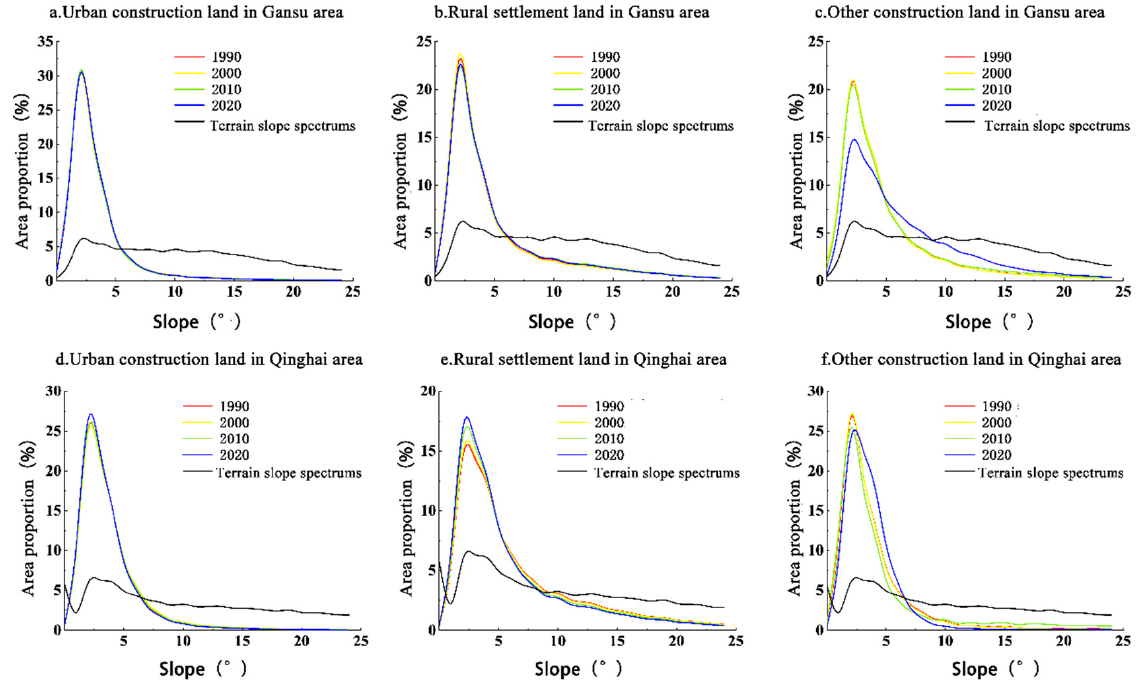
Figure 11. Terrain and construction land slope spectra of two regions within the LXUA from 1990 to 2020.